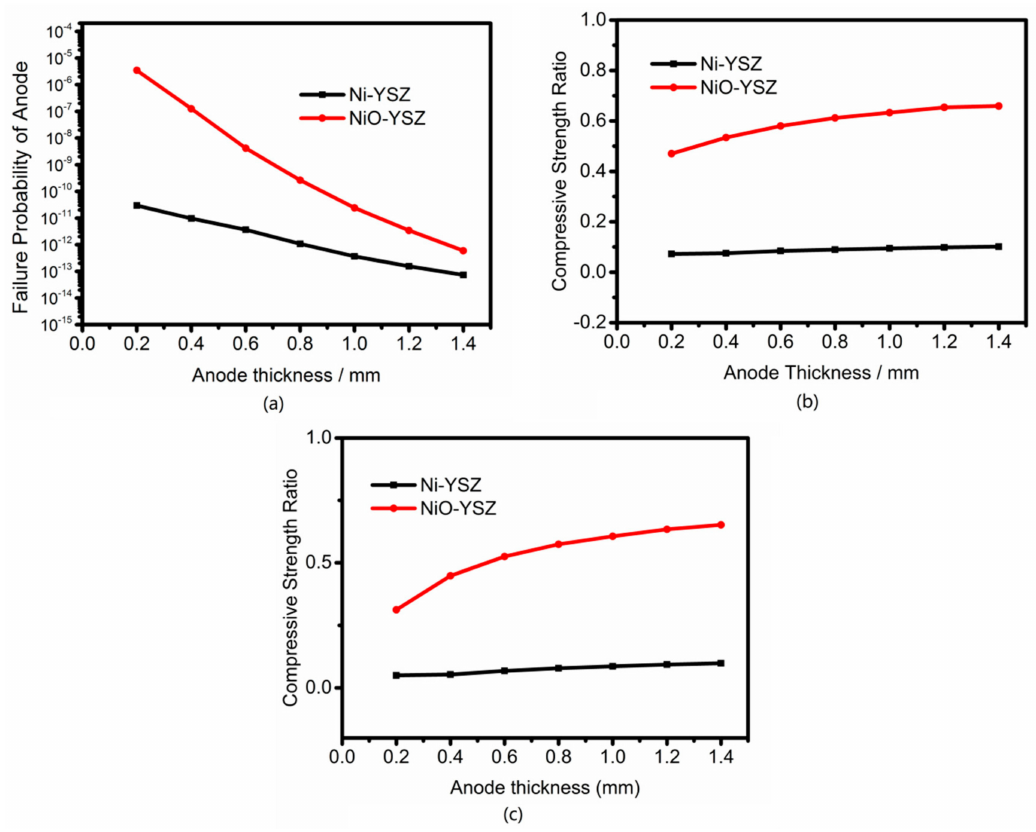
Figure 5. Effects of the anode layer thickness on ( a ) the anode failure probability; ( b ) the compressive stress strength ratio of the electrolyte; ( c ) the compressive stress strength ratio of the cathode. Results corresponding to the Ni-YSZ anode at OT and the NiO-YSZ anode at RT are shown in black and red,